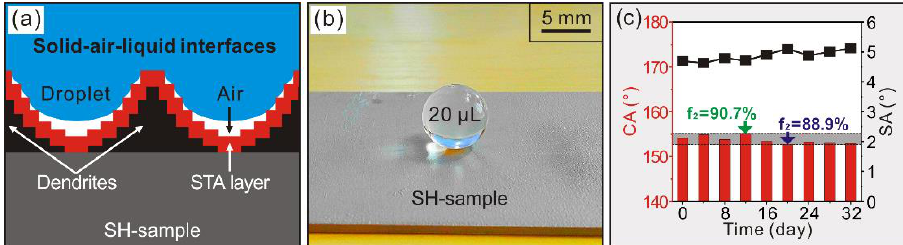
Figure 4. ( a ) Interfacial relationships of modified deposited sample (SH-sample); ( b ) optical photo of